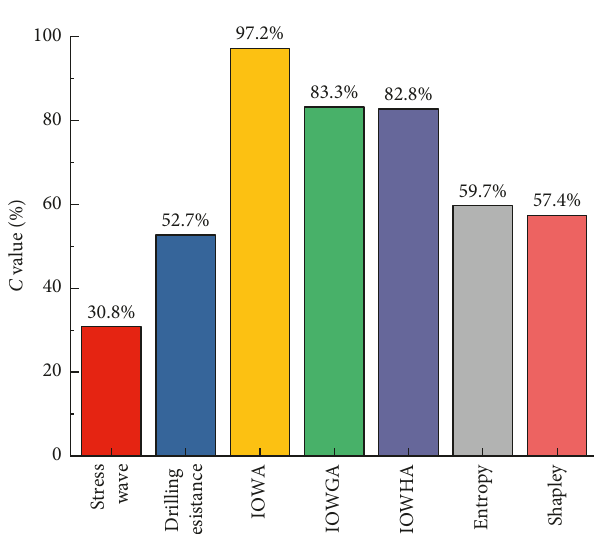
Figure 11: Histograms of the index C .